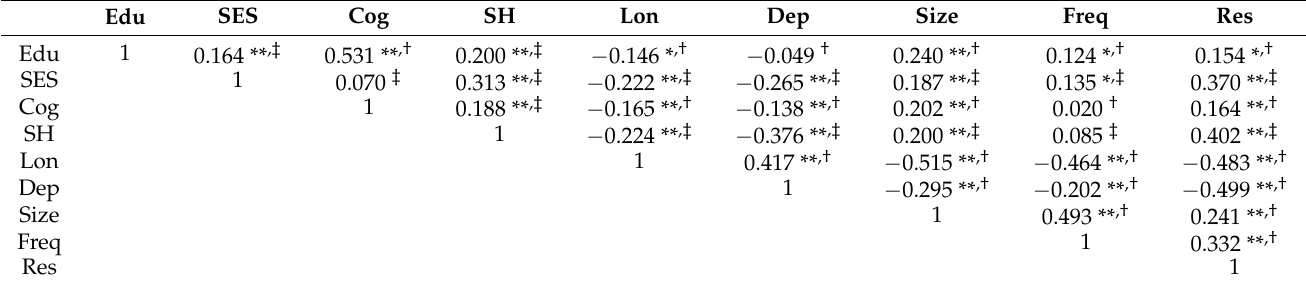
Table 4. Correlation